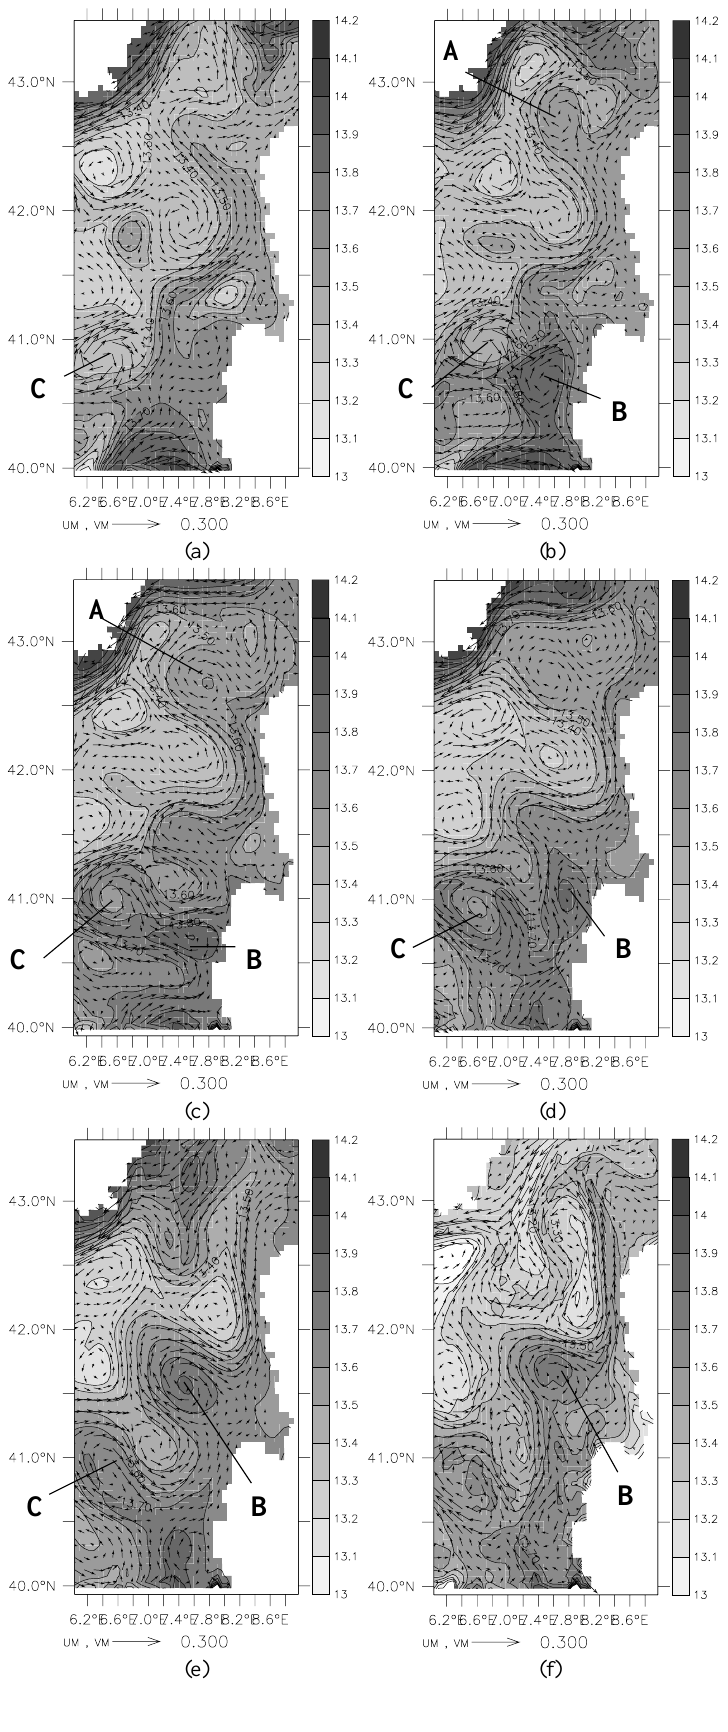
Fig. 4. Monthly mean temperature (shaded, in ◦ C) and velocity (arrows, in m/s) at 100m in: (a) August; (b) September; (c) October; (d) November; (e) December of year II; (f) January